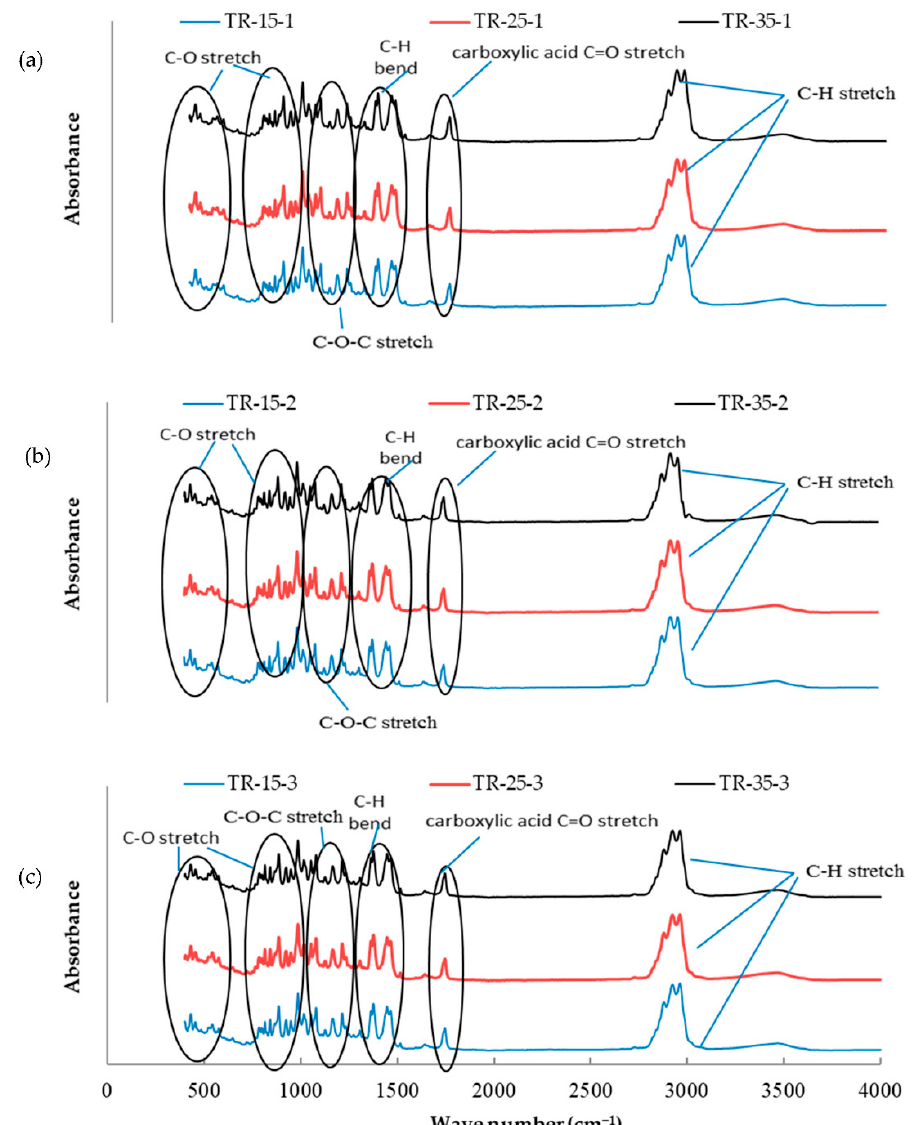
Figure 6. Fourier-transform infrared spectroscopy (FTIR) analysis for the essential oil combination of tea tree + rosemary (TR) at different temperatures (15, 25, and 35 ◦ C) and different times of storage (1–3 months) (different colors refer to different temperature per subfigure). ( a ) This figure refer to the effect of different temperature at 15, 25, and 35 ◦ C on the combination of TR stored for one month; ( b ) the second subfigure refer to different temperature at 15, 25, and 35 ◦ C on the combination of TR stored for two months; ( c ) the third subfigure refer to different temperature at 15, 25, and 35 ◦ C on the combination of TR stored for three months.